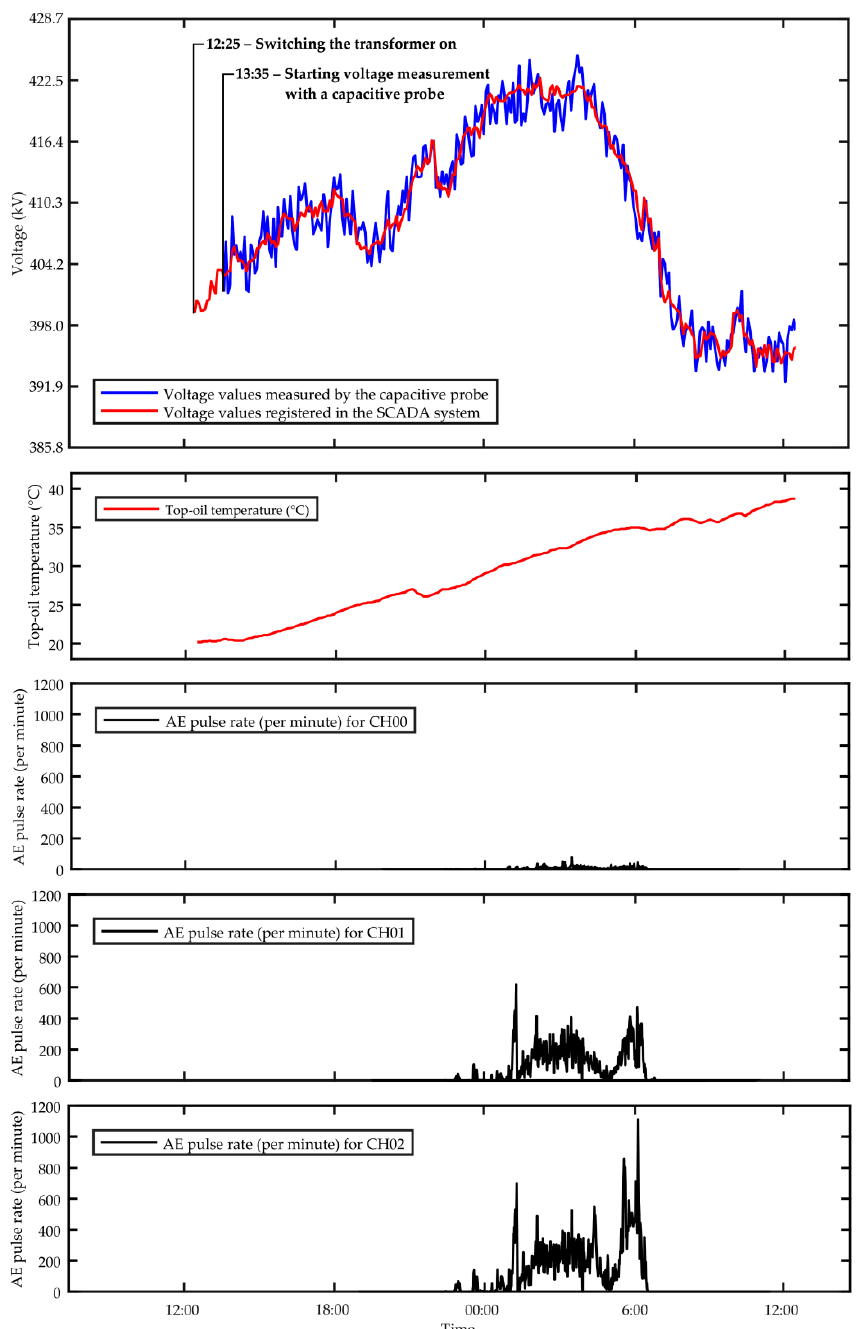
Figure 16. Voltage values measured with a capacitive probe and substation voltage transformer, the top-oil temperature, and the number of AE pulses recorded by three piezoelectric transducers (CH00, CH01, CH02) during 24-hour online monitoring of the 250 MVA power transformer.